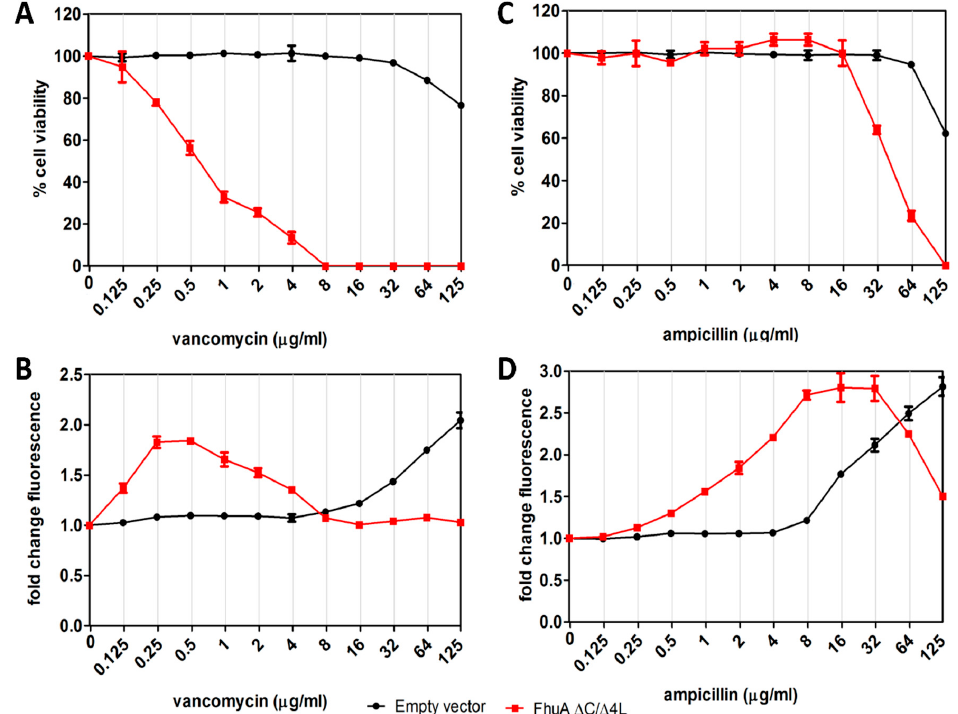
Figure 5. Adapting E. coli to detect Rcs stress responses to large-scaffold antibiotics. E. coli MC4100 cells, harboring an empty pABCON2 (empty vector) or pABCON2-fhuA ∆ C/ ∆ 4L plasmid in combination with pUA66-PrprA-mNG were grown in a 96-well plate and exposed to an increasing concentration of ( A , B ) vancomycin and ( B , D ) ampicillin. Fluorescence was determined 2.5 h after exposure and plotted as OD 600 -corrected fold-change of signal compared to untreated cells (set to 1) as shown in the top panels. The OD 600 -based measurement of cell viability is displayed in the bottom panels, with untreated cells set to 100% cell viability. Error bars represent the standard deviation of duplicate samples. The figure shows a representative example of three independent experiments.